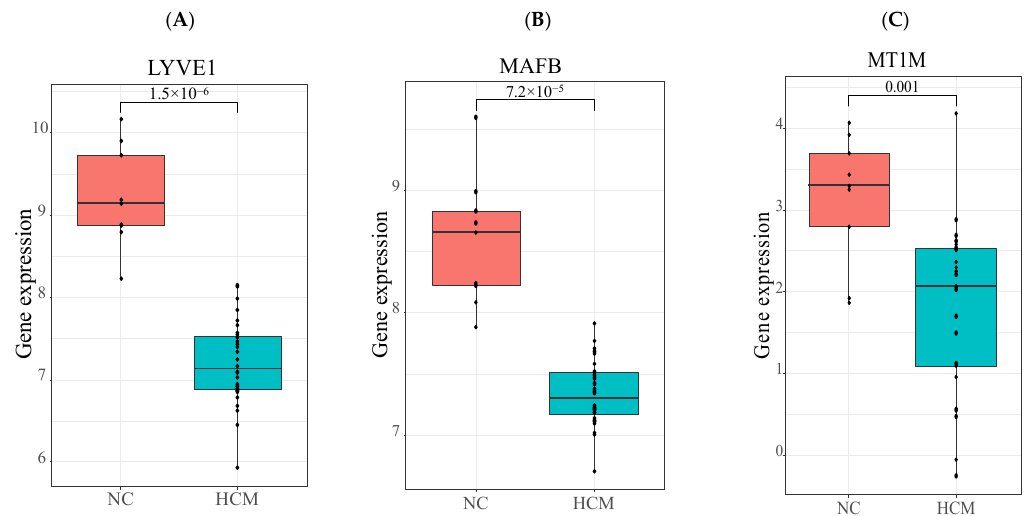
Figure 5. Validation of the differential expressions of three key genes in GSE130036 dataset. ( A ) The differential expression of LYVE1 between HCM and control groups; ( B ) The differential expression of MAFB between HCM and control groups; ( C ) The differential expression of MT1M between HCM and control group. All p < 0.01.